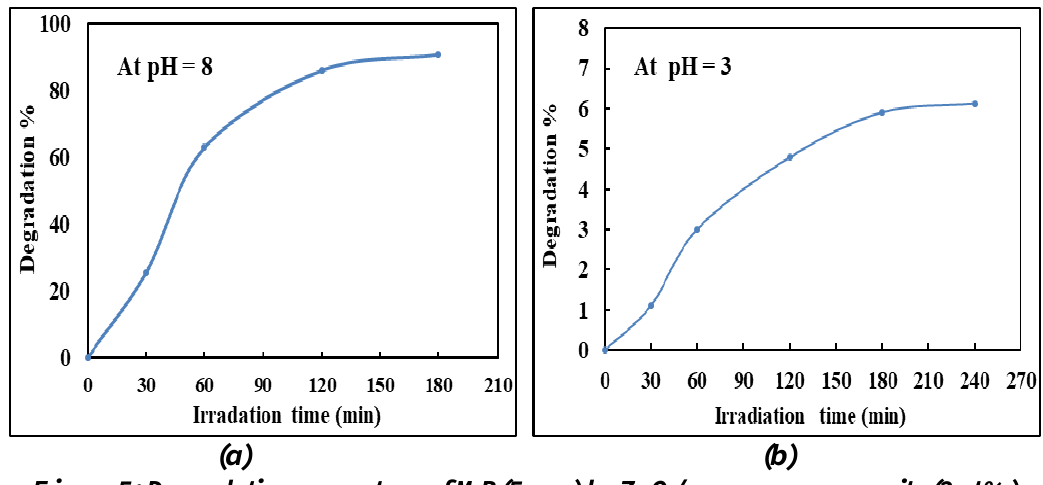
Figure 5: Degradation percentage of MB(5ppm) by ZnO/epoxy nanocomposite (2wt.%) with (a) pH=8, (b) PH=3 verses irradiation time under solar light